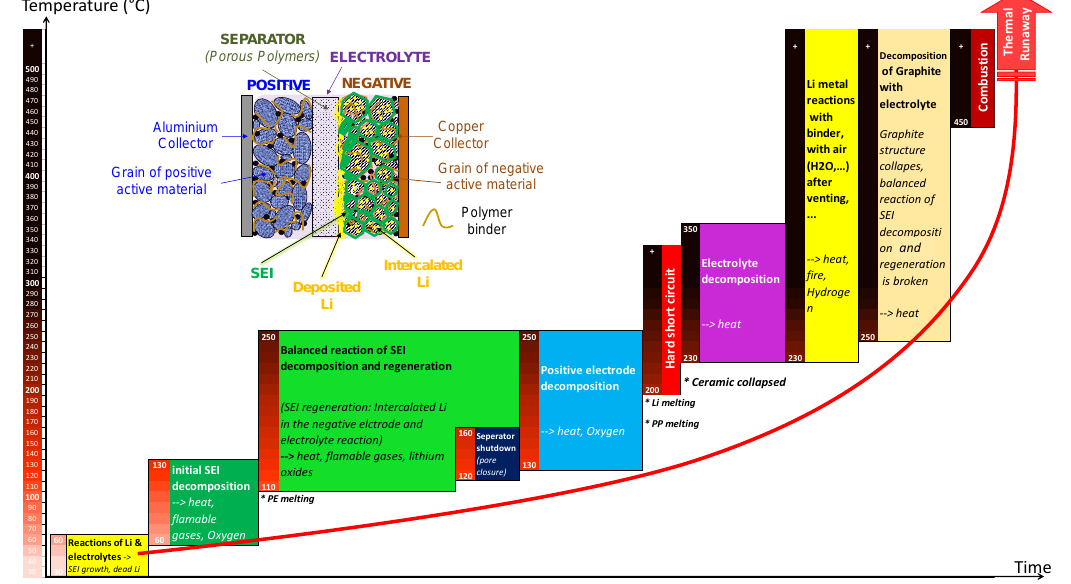
Figure 7. Thermal runaway chain exothermic reactions of Ni-rich lithium-ion batteries.